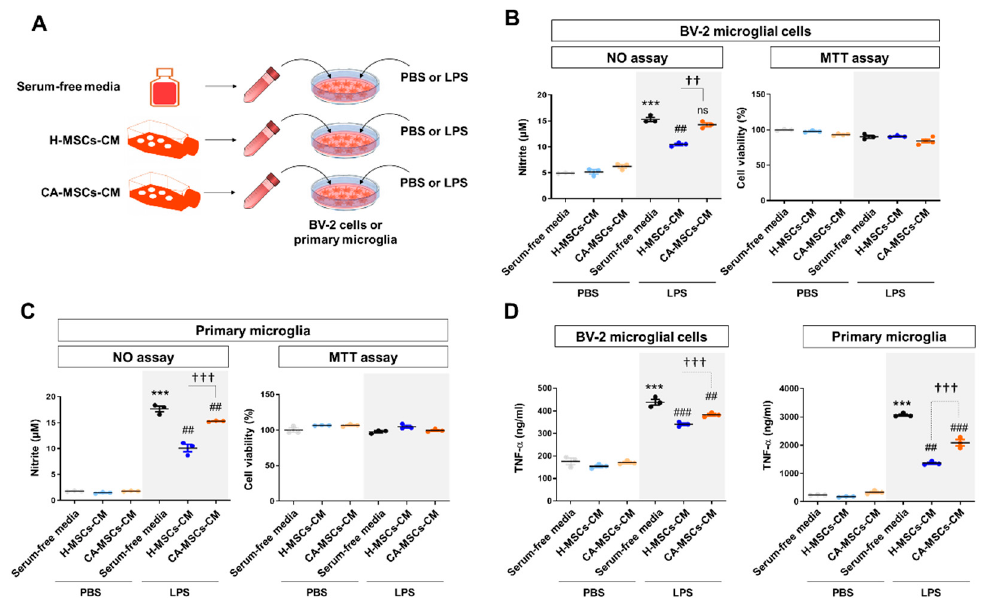
Figure 2. Characteristics of the immunomodulatory potential of MSCs derived from CA-MSCs on microglial activation. ( A ) Schematic drawing of the experimental procedure. The conditioned medium obtained from MSCs culture (MSCs-CM) was added with / without lipopolysaccharide (LPS) (100 ng / mL) to BV-2 microglial cells or primary microglia for 24 h. ( B , C ) Nitric oxide assay in BV-2 cells and primary microglia cell culture was performed in triplicate. Nitric oxide production was measured using Griess reagents and was used to indicate microglial activation. ( D ) TNF- α production in BV-2 cells and primary microglia cell culture was measured in triplicate. The TNF- α level was measured using an enzyme-linked immunosorbent assay. Results are presented as mean ± SEM obtained from MSC culture (MSC-CM) from healthy subjects ( n = 3) or CA patients ( n = 3). One-way analysis of variance was followed by the Tukey post-hoc test. *** p < 0.001 vs. control; ## p < 0.01, ### p < 0.001 vs. control + LPS; †† p < 0.01, ††† p < 0.001 vs. healthy MSC-CM + LPS. ns, not significant.